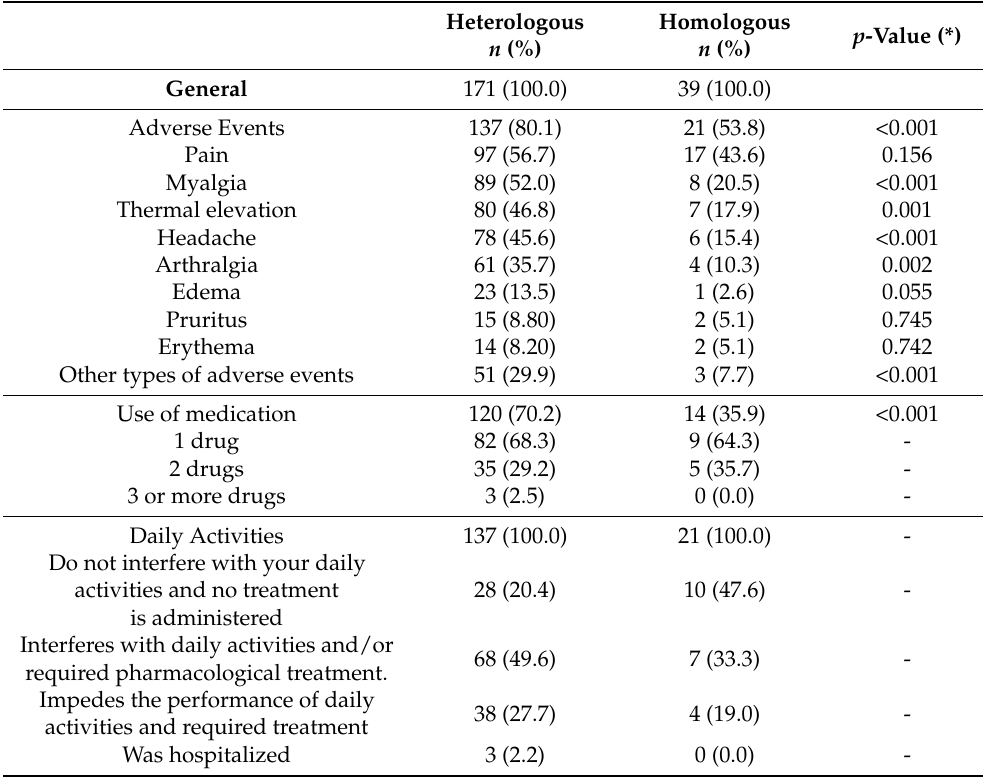
Table 4. Adverse events after vaccination medication, and relationship to daily activities: heterolo- gous vs. homologous.